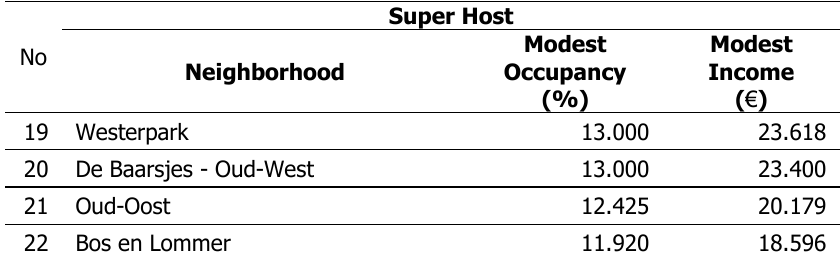
Normal Host Modest Occupancy (%)